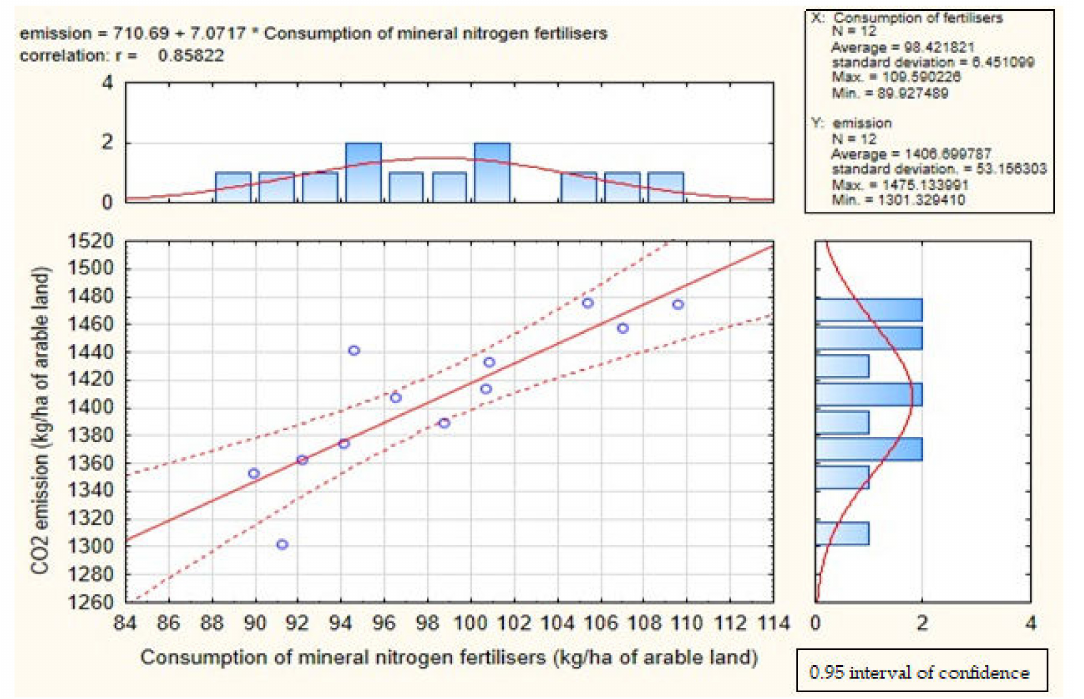
Figure A4. Results of correlations analysis: Poland. Source: own calculation based on Eurostat. Note: purple dot: observation, red solid line: linear function, red dashed lines: 95% interval of confidence.